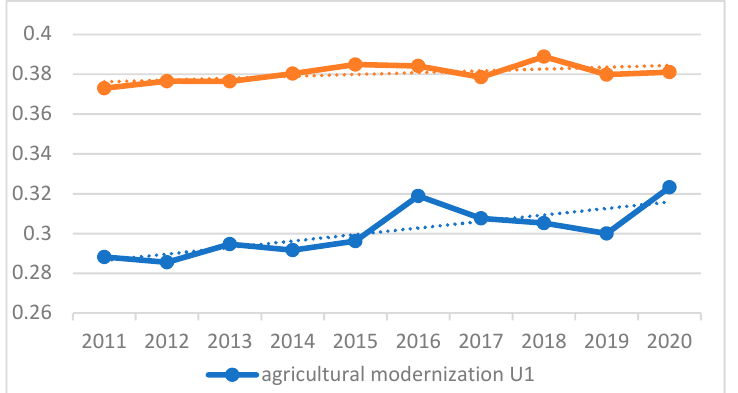
Figure 2. The trend of the comprehensive evaluation index of agricultural modernization and regional economic development.